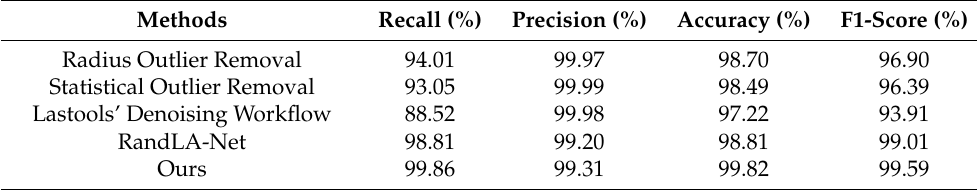
Table 3. Performance evaluation of the compared approaches and ours in the suburban area.